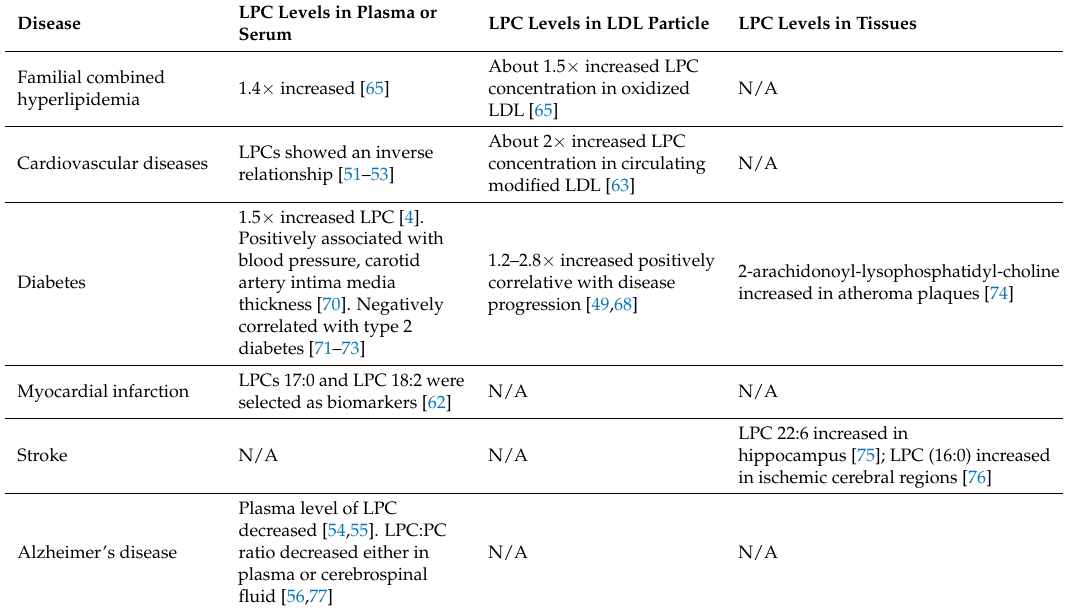
Table 2. LPC levels in circulation, LDL, or